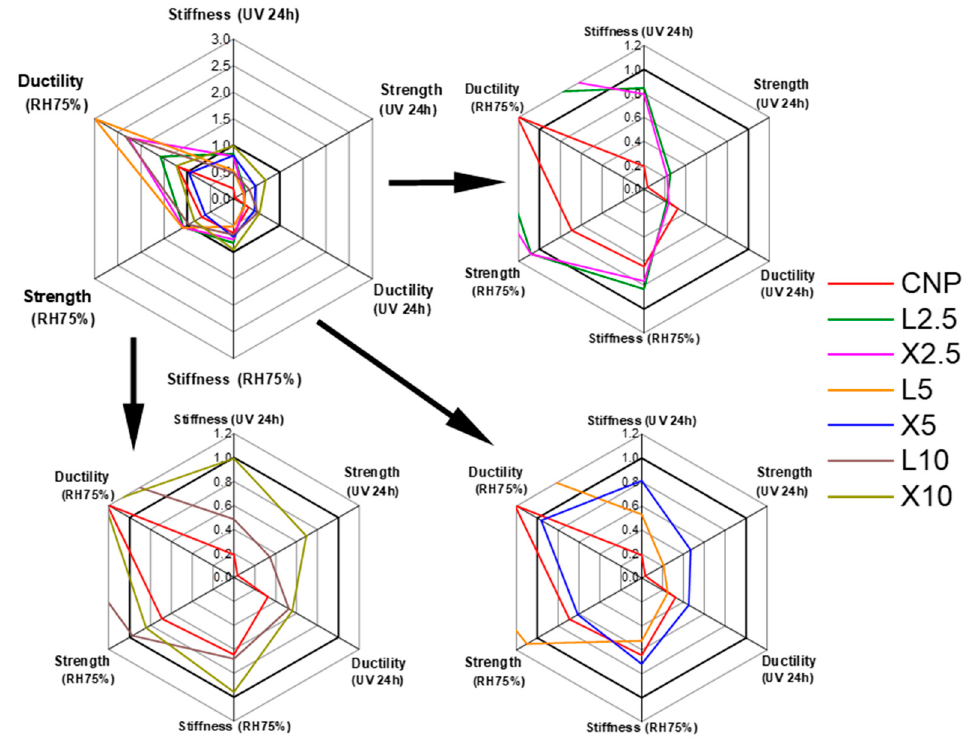
Figure 13. Relative changes of performance properties for NPs before and after aging. For reference, dry samples were used for UV and samples saturated at RH24% were used for water adsorption impacts. Value 1 represents the sample before aging.